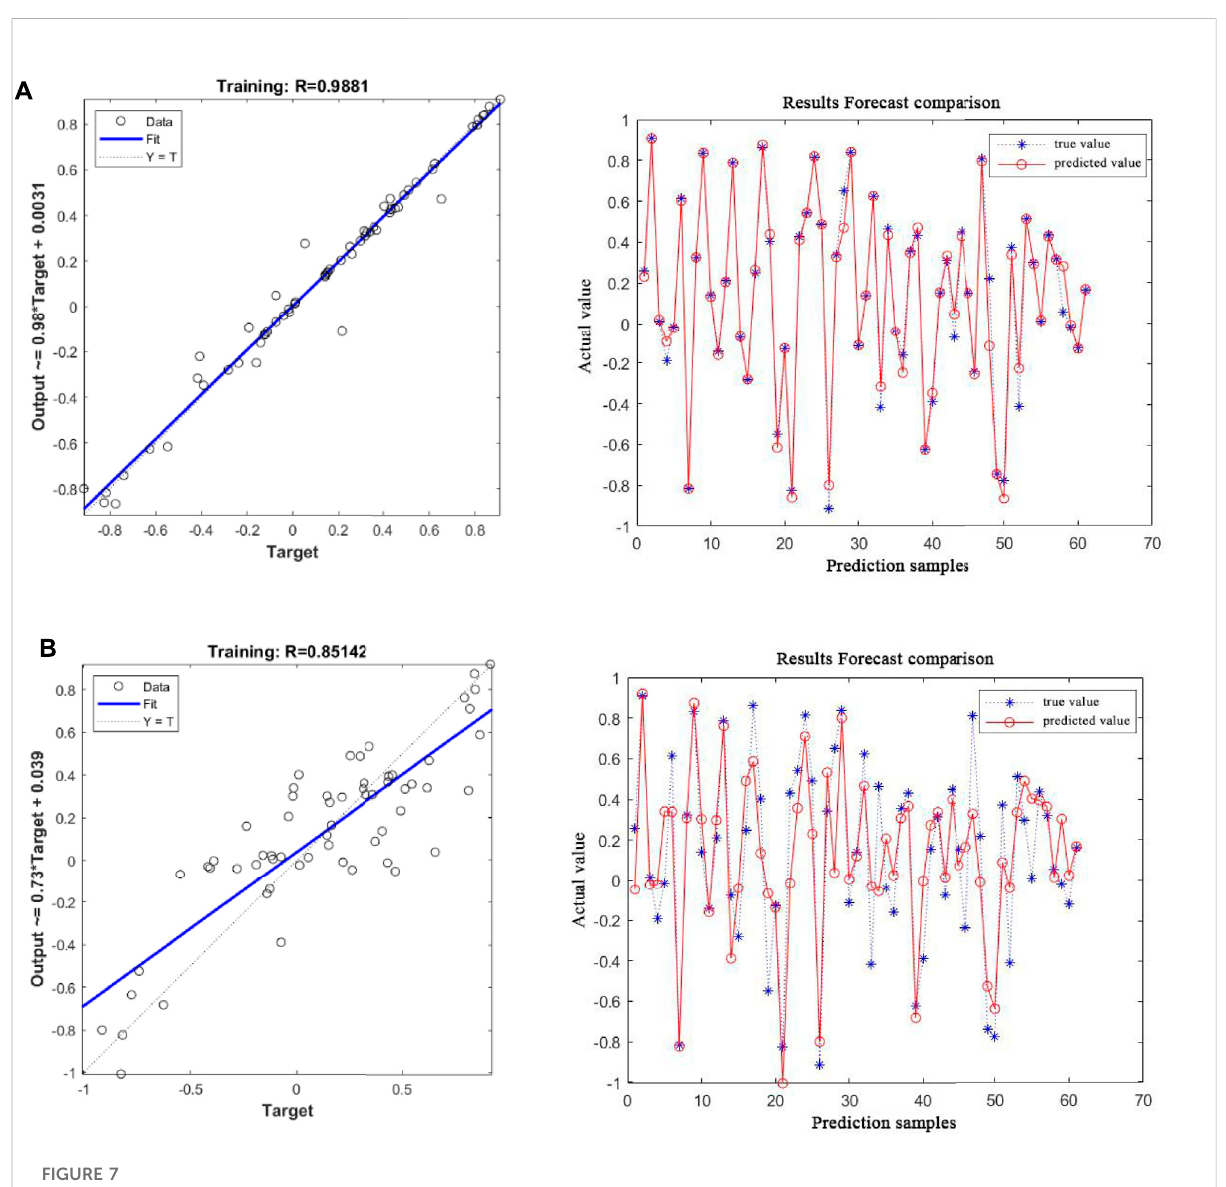
Comparison of the strength prediction results: (A) GWO-BP, (B)